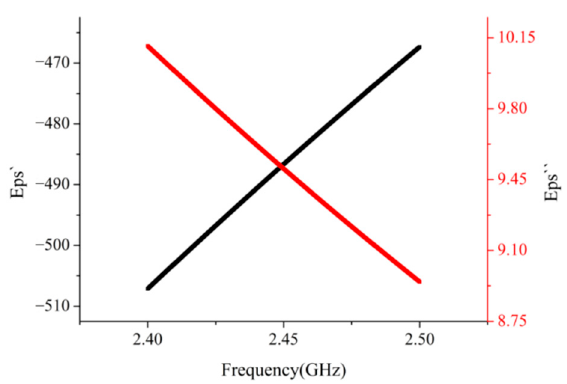
Figure 4. Dispersion